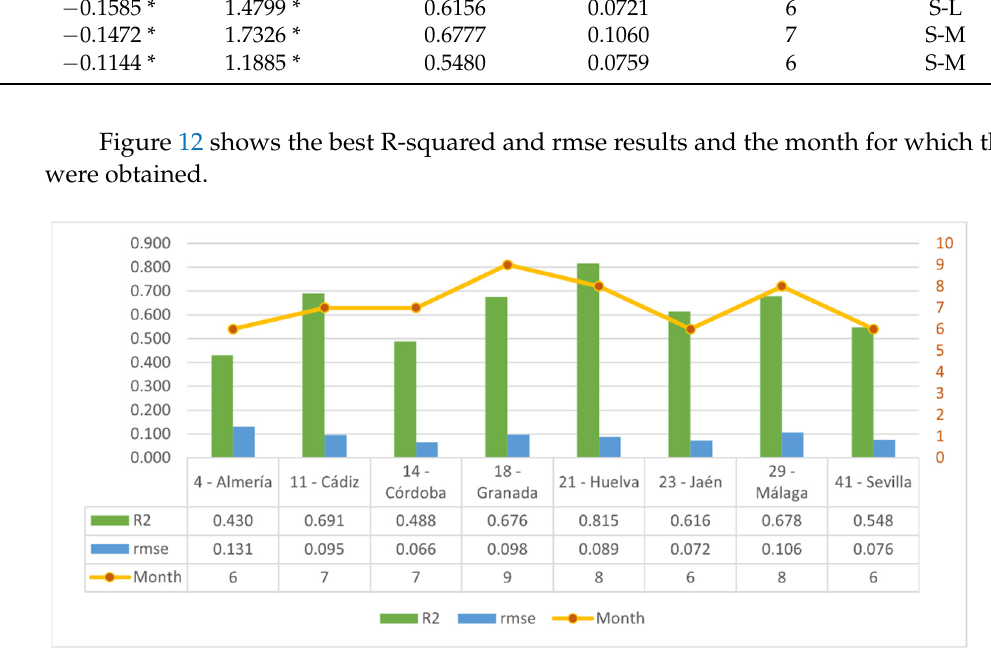
Figure 12. Month in which the best Rsquared and rmse results were obtained for the StatsModel multiple linear regression for each province.